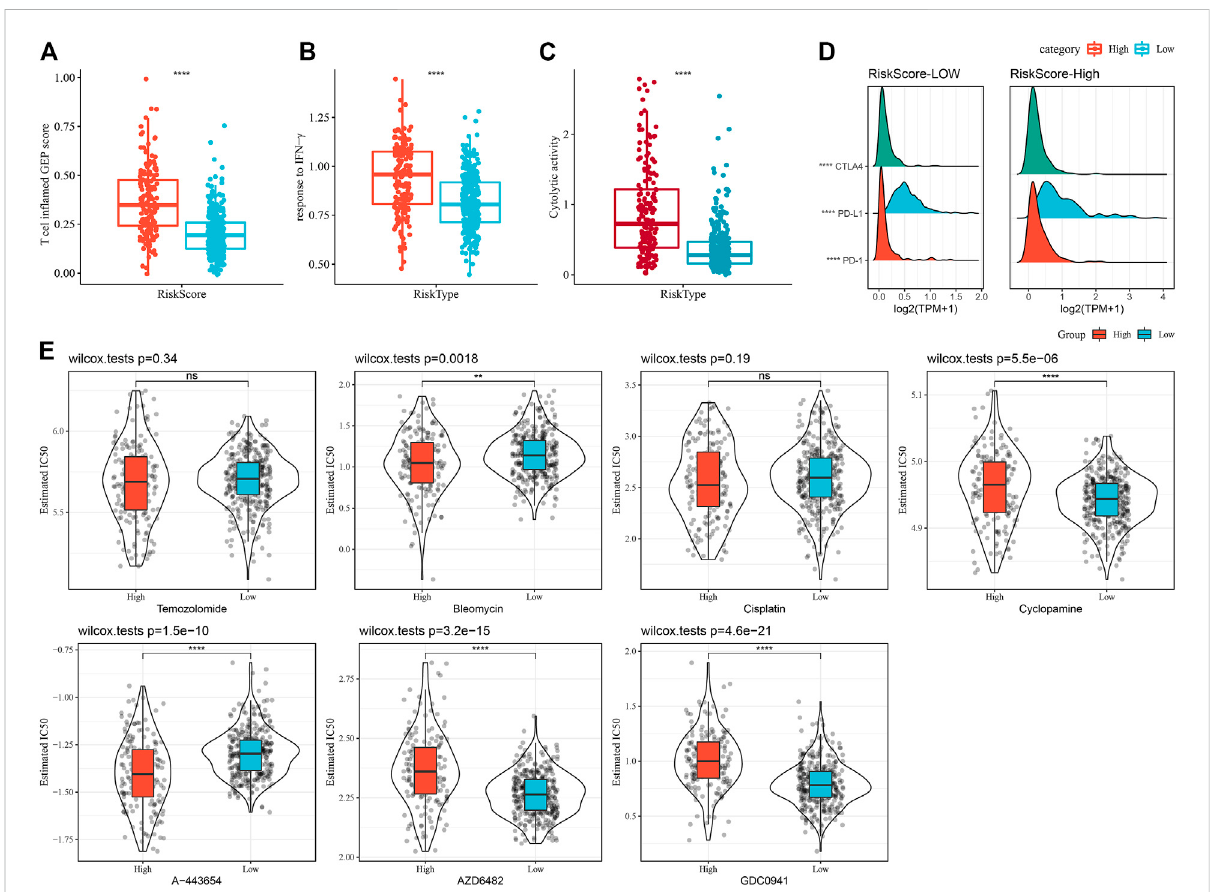
FIGURE 12 Immune characteristic scores re fl ect the effect of immunotherapy in different RiskScore subgroups. (A) Differences in T cell in fl amed GEP scores between different molecular subtypes. (B) Variations in response to IFN- γ between different molecular subtypes. (C) Variations in cytolytic activitybetweendifferentmolecularsubtypes. (D) Differencesinexpression ofimmunecheckpoint genesinvariousmolecularsubtypes. (E) Thebox plots of the estimated IC50 for Temozolomide, Bleomycin, Cisplatin, Cyclopamine, A- 443654, AZD6482, and GDC0941 in